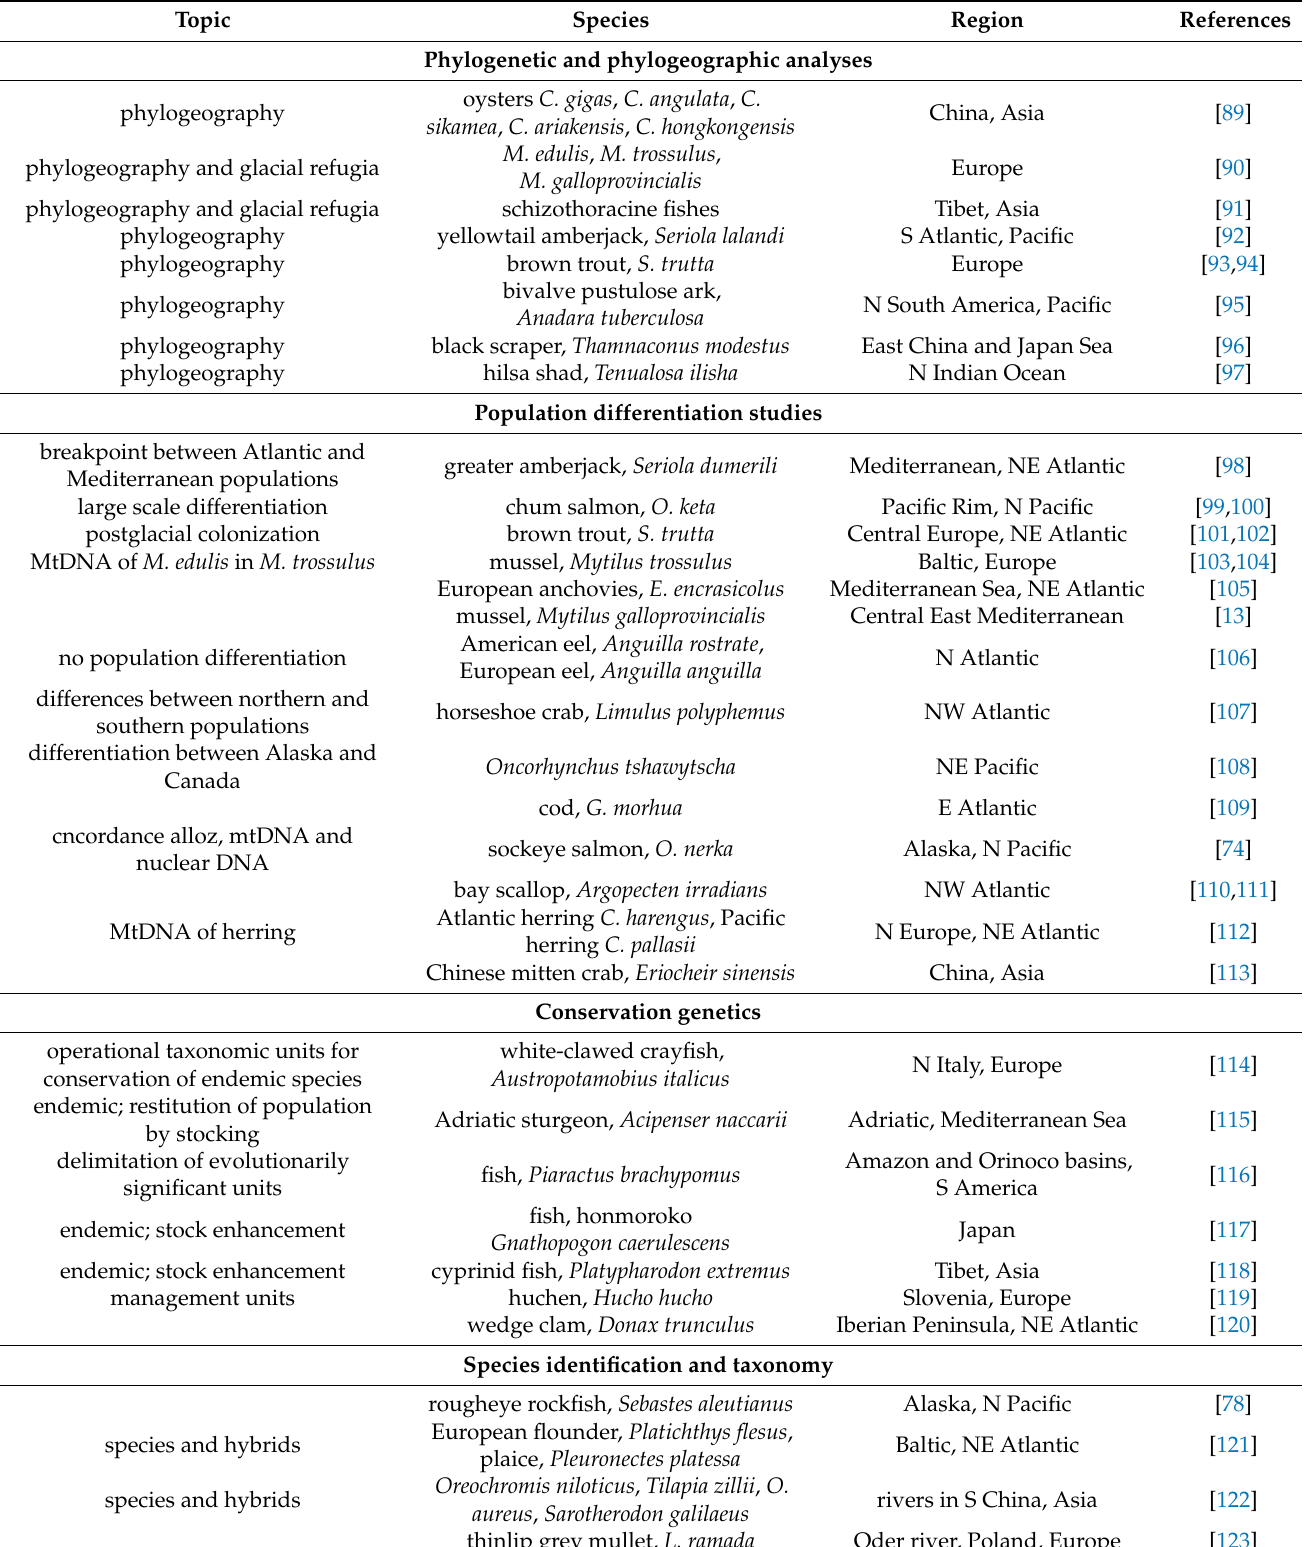
Table 2. Examples of mitochondrial DNA applications in studies of aquatic